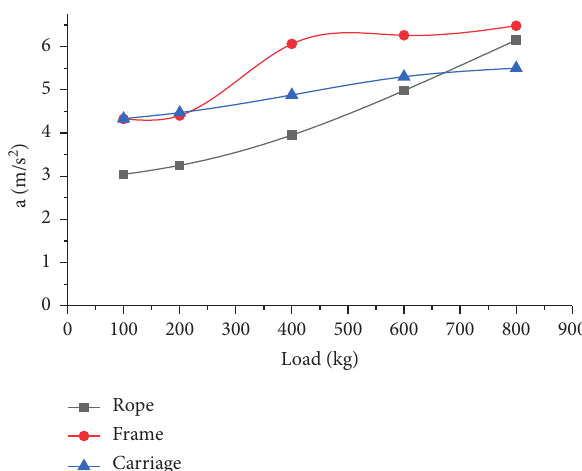
Figure 10: Deceleration peaks during the upward emergency